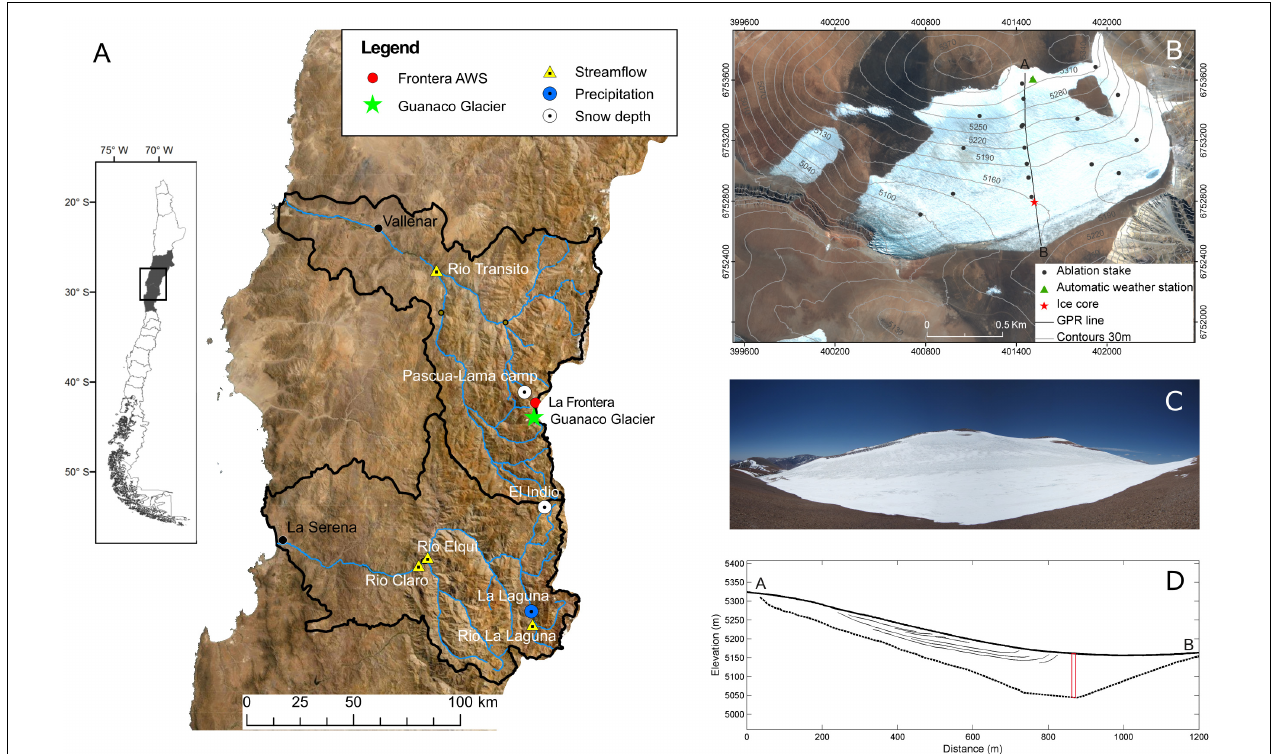
FIGURE 1 | Study area and sites. (A) region map showing the location of Guanaco Glacier and the hydroclimatic records used in this study. (B) Map of Guanaco Glacier showing mass balance stakes, automatic weather station and ice coring site; satellite image: Ikonos, March 26, 2007. (C) photograph of Guanaco Glacier taken from point B, looking North. (D) Surface and subglacial topography along GPR profile shown in (C) with mapped reflectors and ice core location shown in